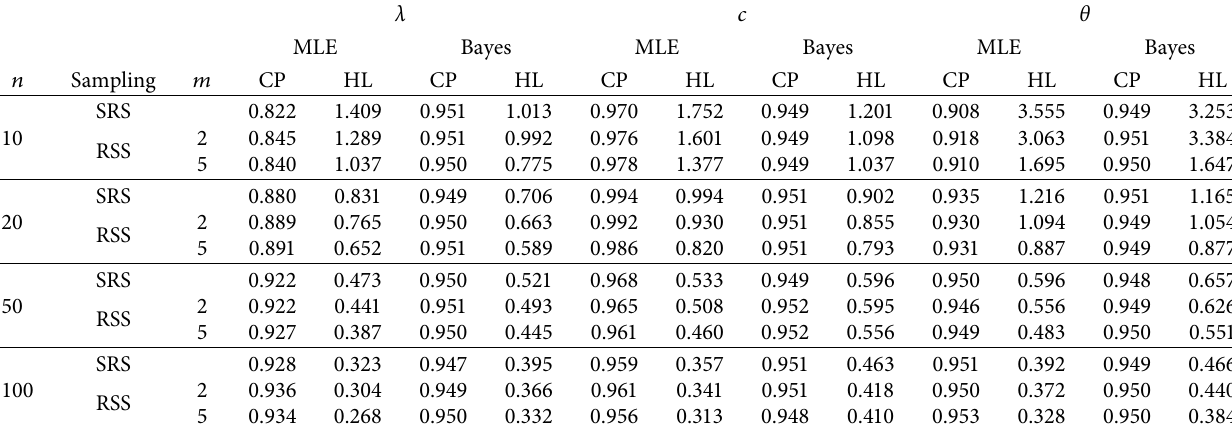
Table 5: Coverage probability (CP) and half length (HL) of the MLE and Bayes estimates under RSS and SRS for different sample sizes and